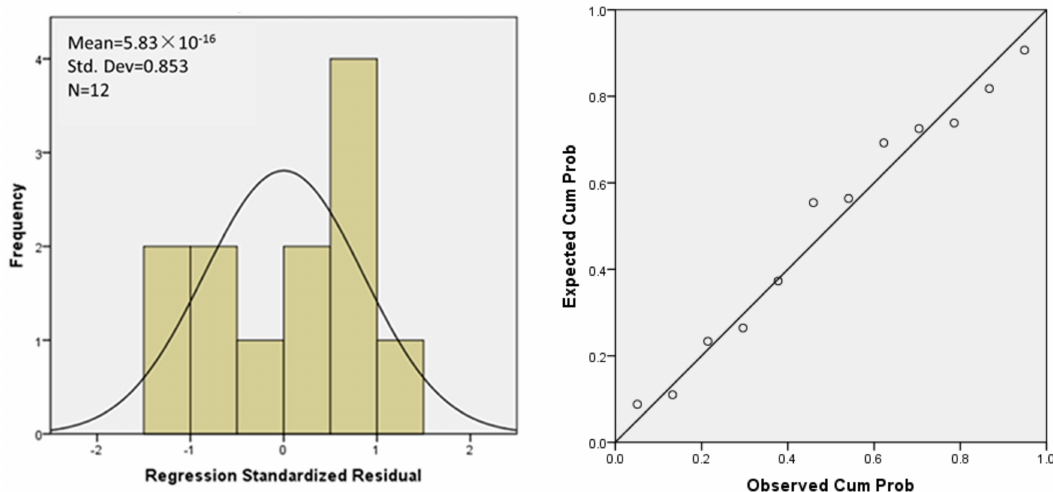
Figure 7. Residual analysis results for debris flow average velocity V vs. flow rate Q , slope S and the vertical grading coefficient Ψ .